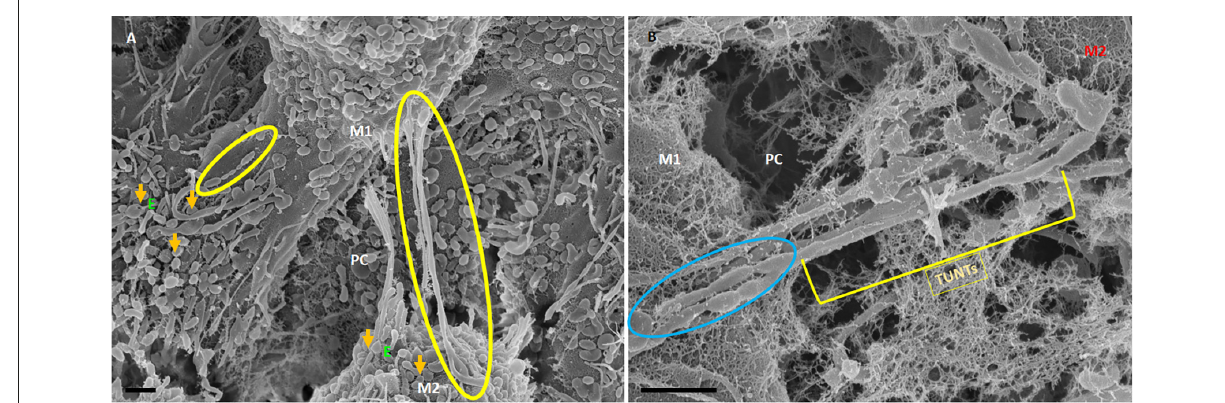
FIGURE6 HR-SEM micrographs depicting bEnd5 exosome expression on a target cell. (A) An HR-SEM micrograph displaying TF-exosome-induced TUNT generation. Scale bar = 1,000 nm on a recipient cell M2. (B) A 200 nm micrograph of the open-ended TUNT formation, scale bar = 1,000 nm. E denotes clusters of exosome accumulation on the BEC membrane, the orange arrows indicate individual exosomes, M1 and M2 denote the porous membranes of the BEC from which NT originates (M1) and the target cell membrane (M2), the yellow circle and TUNT indicate tunneling nanotubes across PC, denotes the paracellular space. Scale bar 1,000 nm.